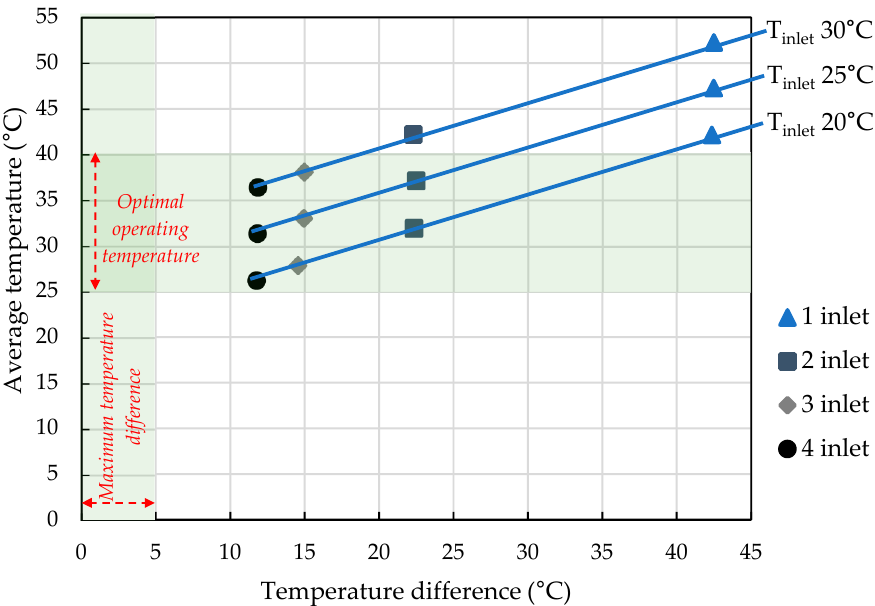
Figure 8. Temperature distribution of LBM model.